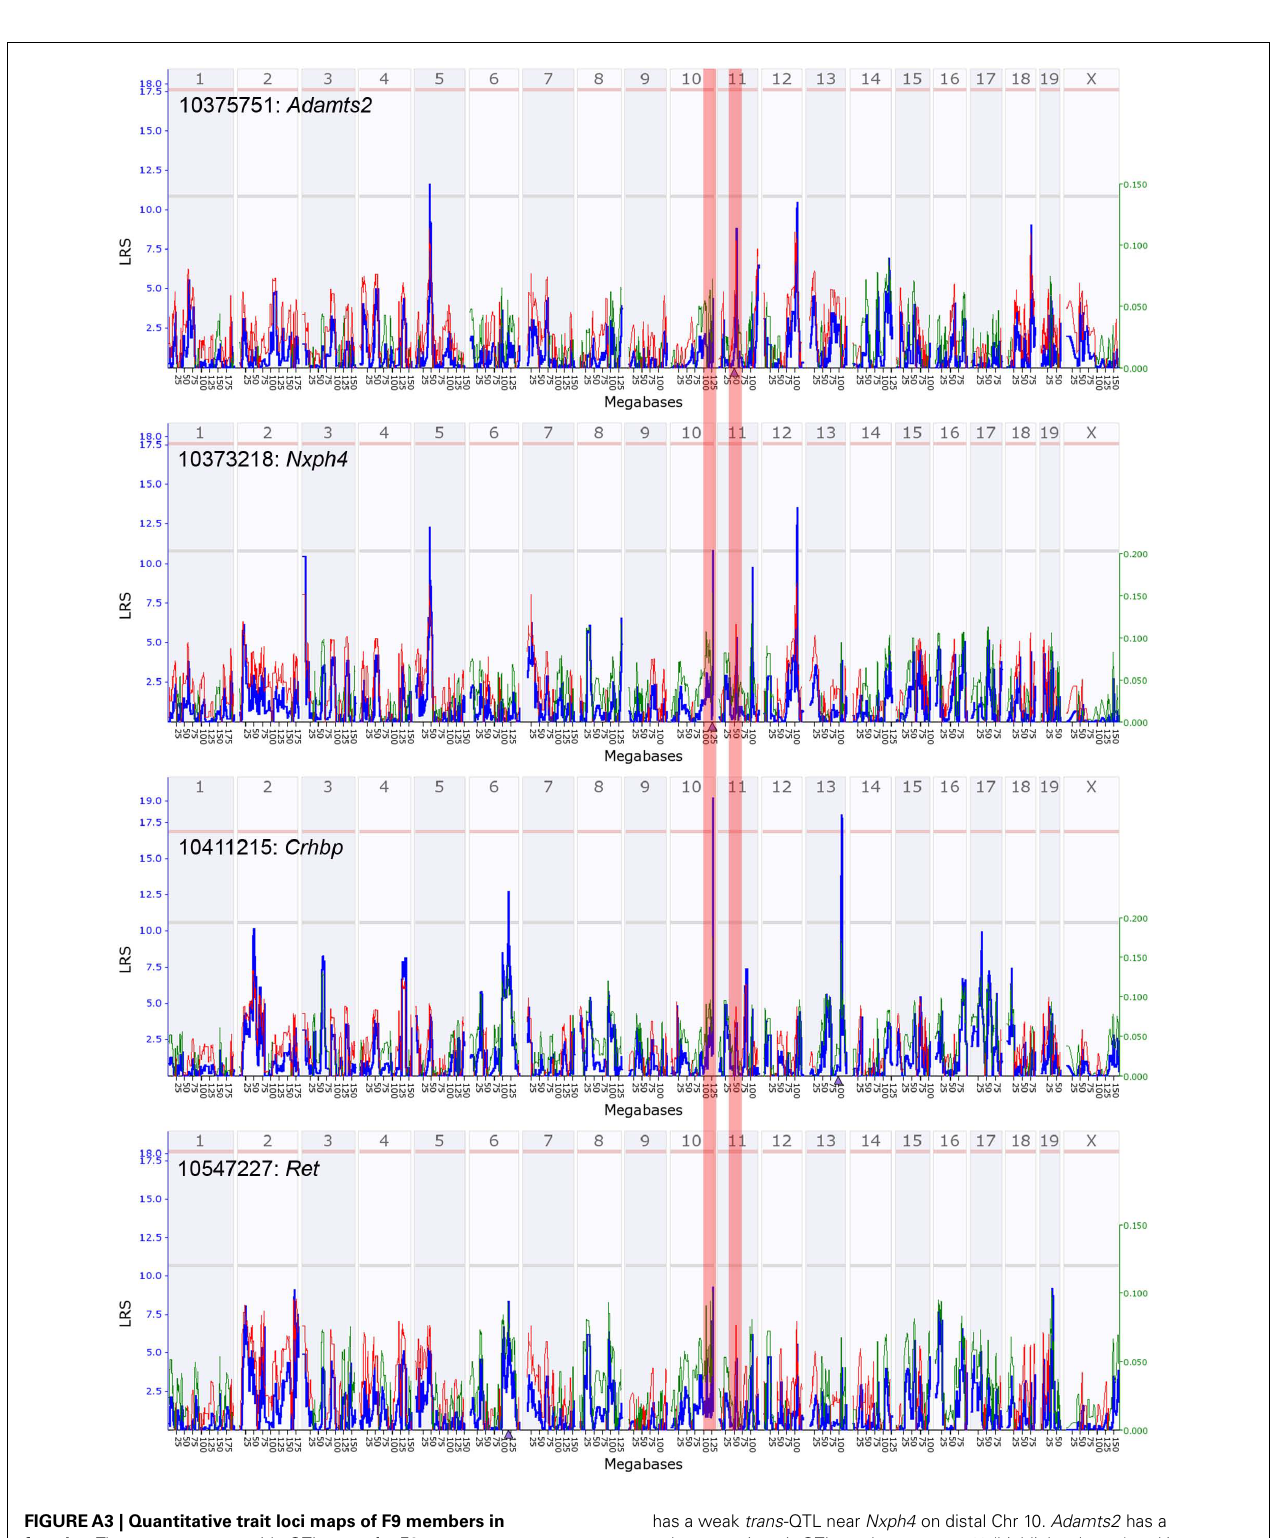
FIGUREA3 | Quantitative trait loci maps of F9 members in females. These are genome-wide QTL maps for F9 members – Adamts2 , Nxph4 , Crhbp , and Ret .The Nxph4 transcript has a suggestive cis- QTL on distal chromosome 10 (highlighted zone). Crhbp has a significant trans -QTL on distal chromosome 10. Ret also